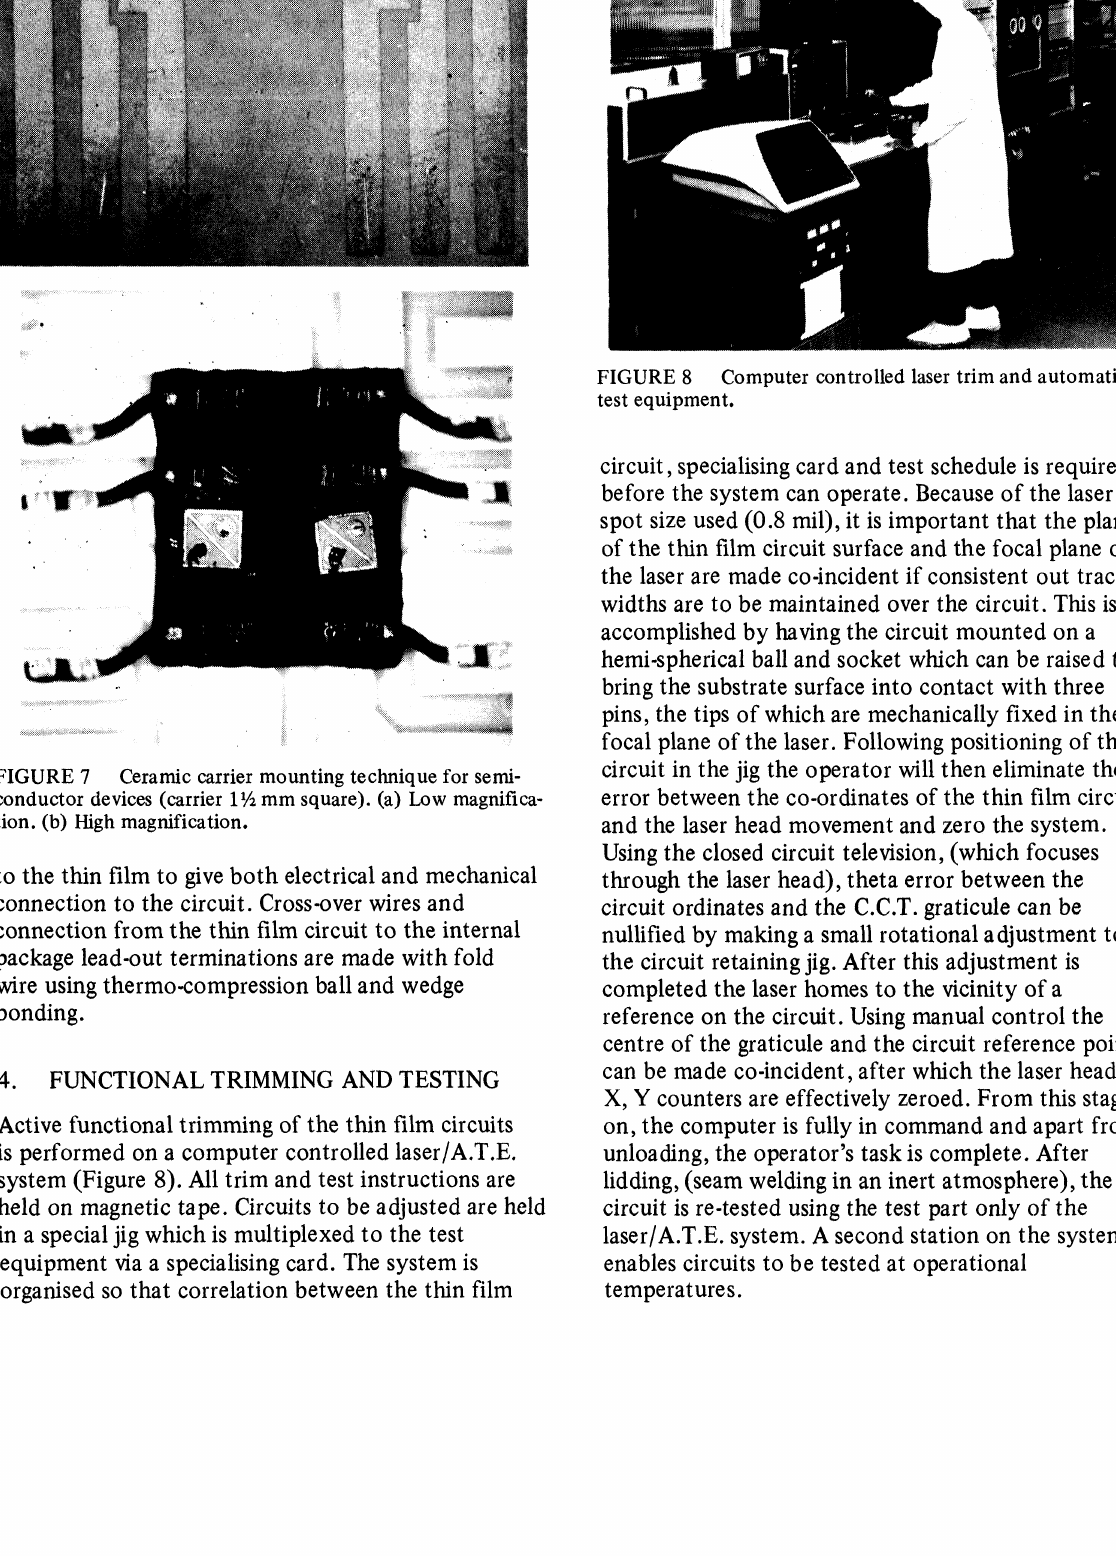
FIGURE 8 Computer controlled laser trim and automatic test